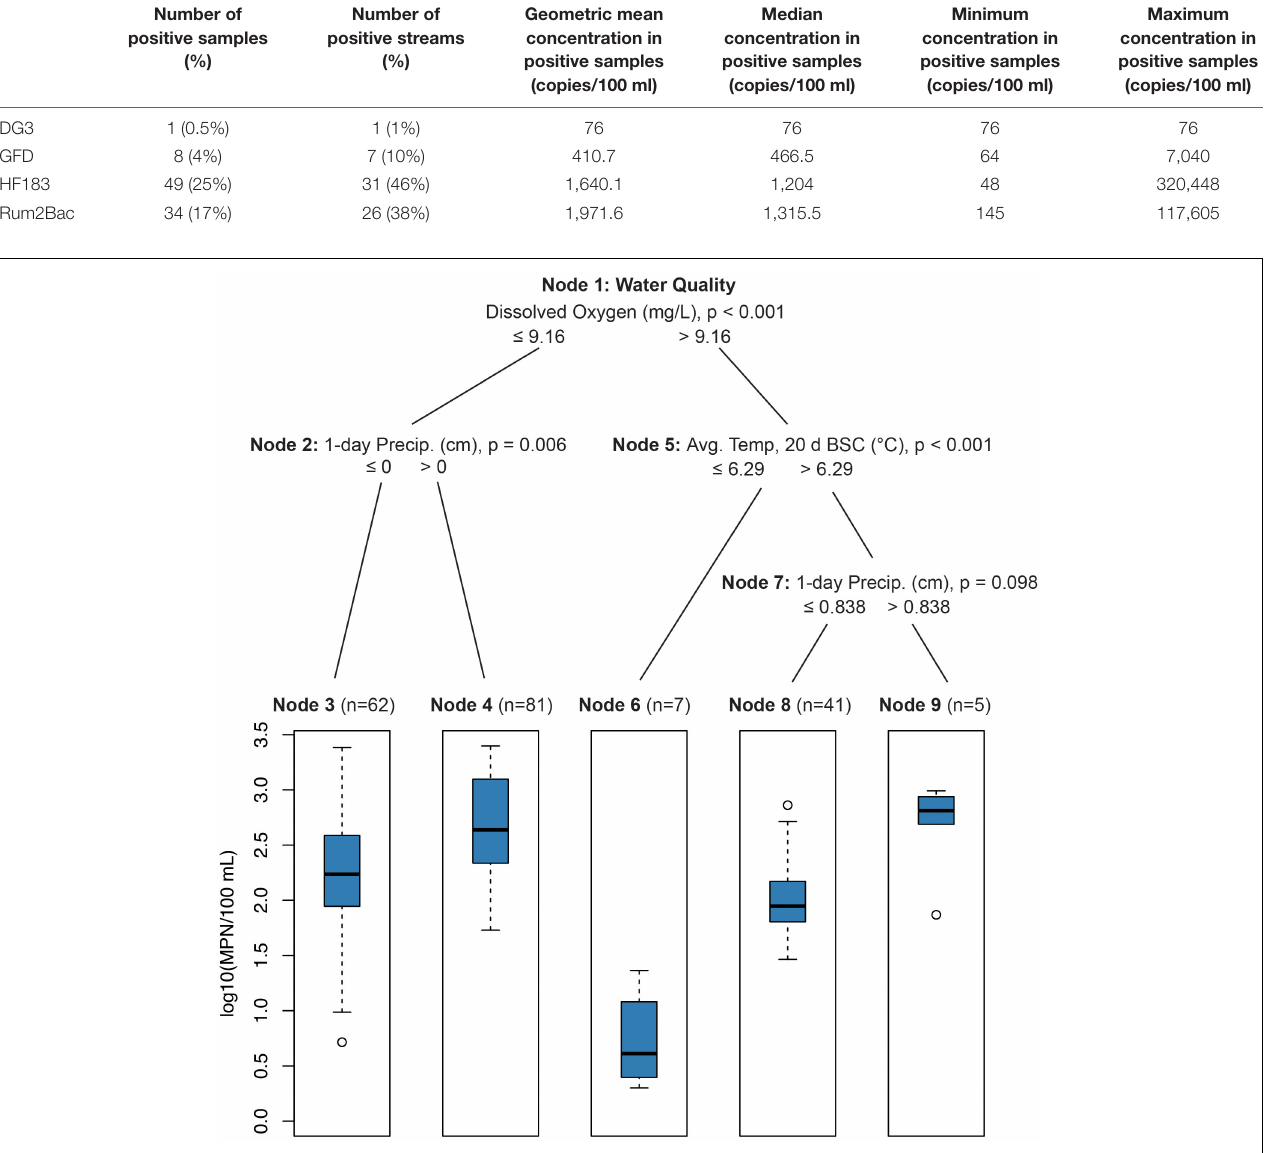
FIGURE 1 | Conditional inference tree (CTree) showing factors and combinations of factors predictive of log 10 E. coli /100 ml. In Node 1, dissolved oxygen was designated the primary split ( p < 0.001), while pH (split = 8.26, p < 0.022) and turbidity (split = 0.50 log 10 NTUs, p < 0.001) were designated surrogate splits that split the data equally well. Turbidity was the only significant surrogate split for Node 2 (split = 0.86 log 10 NTUs, p < 0.007). For Node 5, average 10-day (split = 23.6 ◦ C, p < 0.003) and 30-day (split = 24.6 ◦ C, p < 0.002) temperatures were significant surrogates. Node 7 had no significant